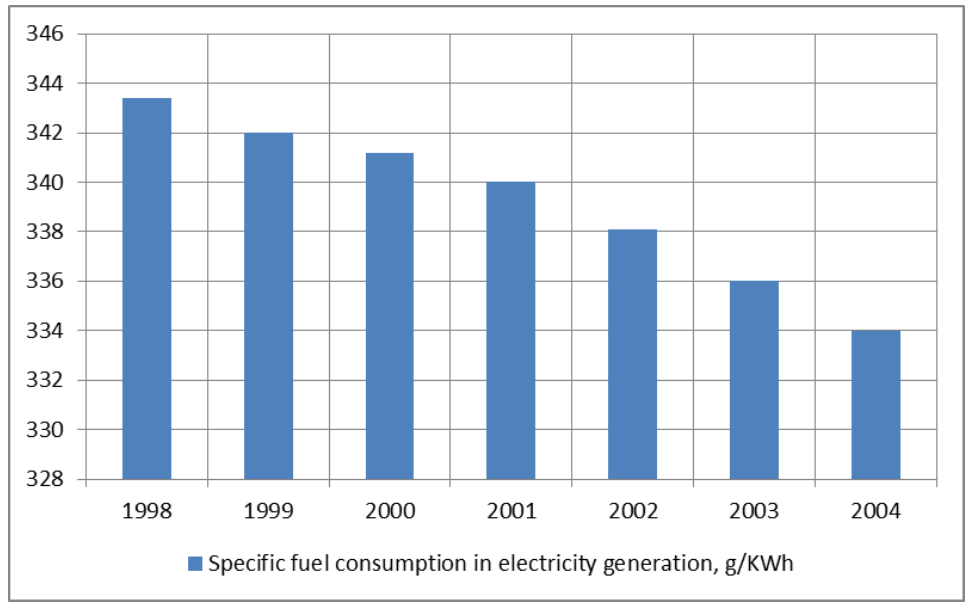
Figure 1: Specific fuel consumption in electricity generation in